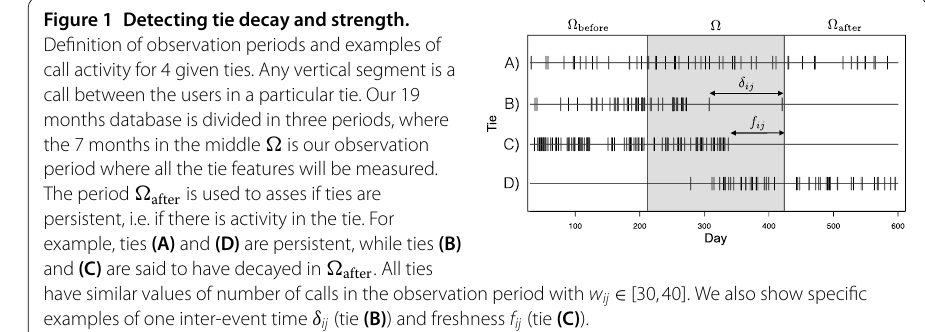
Figure 1 Detecting tie decay and strength. Definition of observation periods and examples of call activity for 4 given ties. Any vertical segment is a call between the users in a particular tie. Our 19 months database is divided in three periods, where the 7 months in the middle (cid:2) is our observation period where all the tie features will be measured. The period (cid:2) after is used to asses if ties are persistent, i.e. if there is activity in the tie. For example, ties (A) and (D) are persistent, while ties (B) and (C) are said to have decayed in (cid:2) after . All ties have similar values of number of calls in the observation period with w ij ∈ [30,40]. We also show specific examples of one inter-event time δ ij (tie (B) ) and freshness f ij (tie (C)